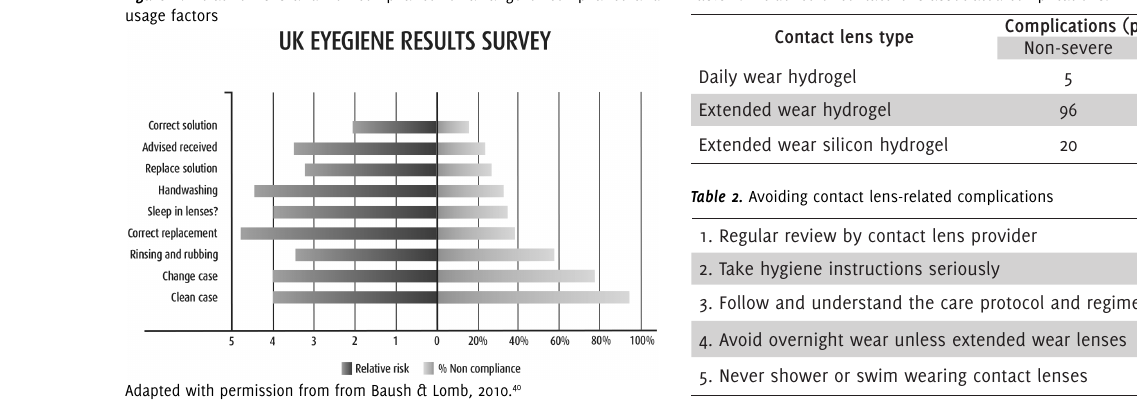
Table 1. Incidence of contact lens-associated complications. 7